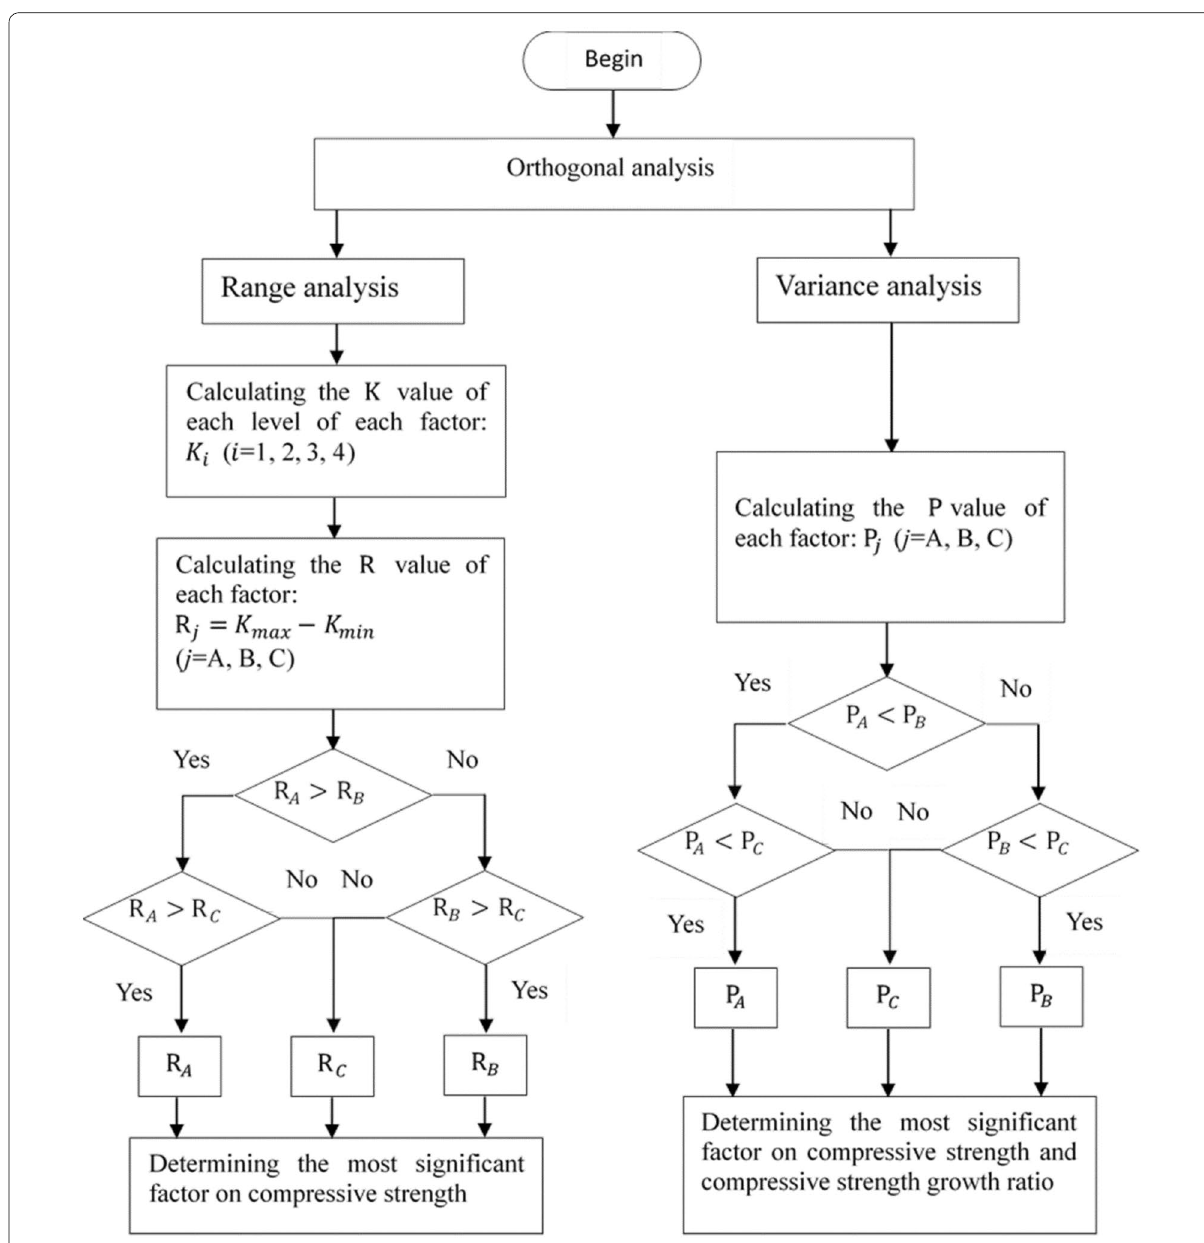
Fig. 14 Flowchart of the orthogonal